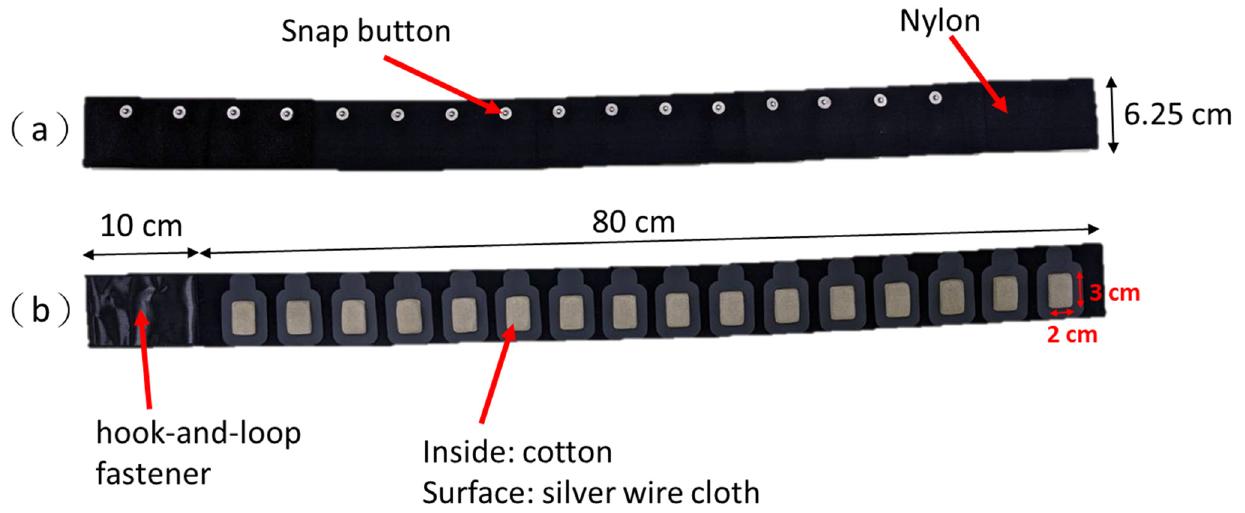
Figure 3. A wearable textile-electrode electrical impedance tomography (EIT) belt. ( a ) The back of the EIT belt with 16 snap buttons. ( b ) The front of the EIT belt with 16 textile electrodes.